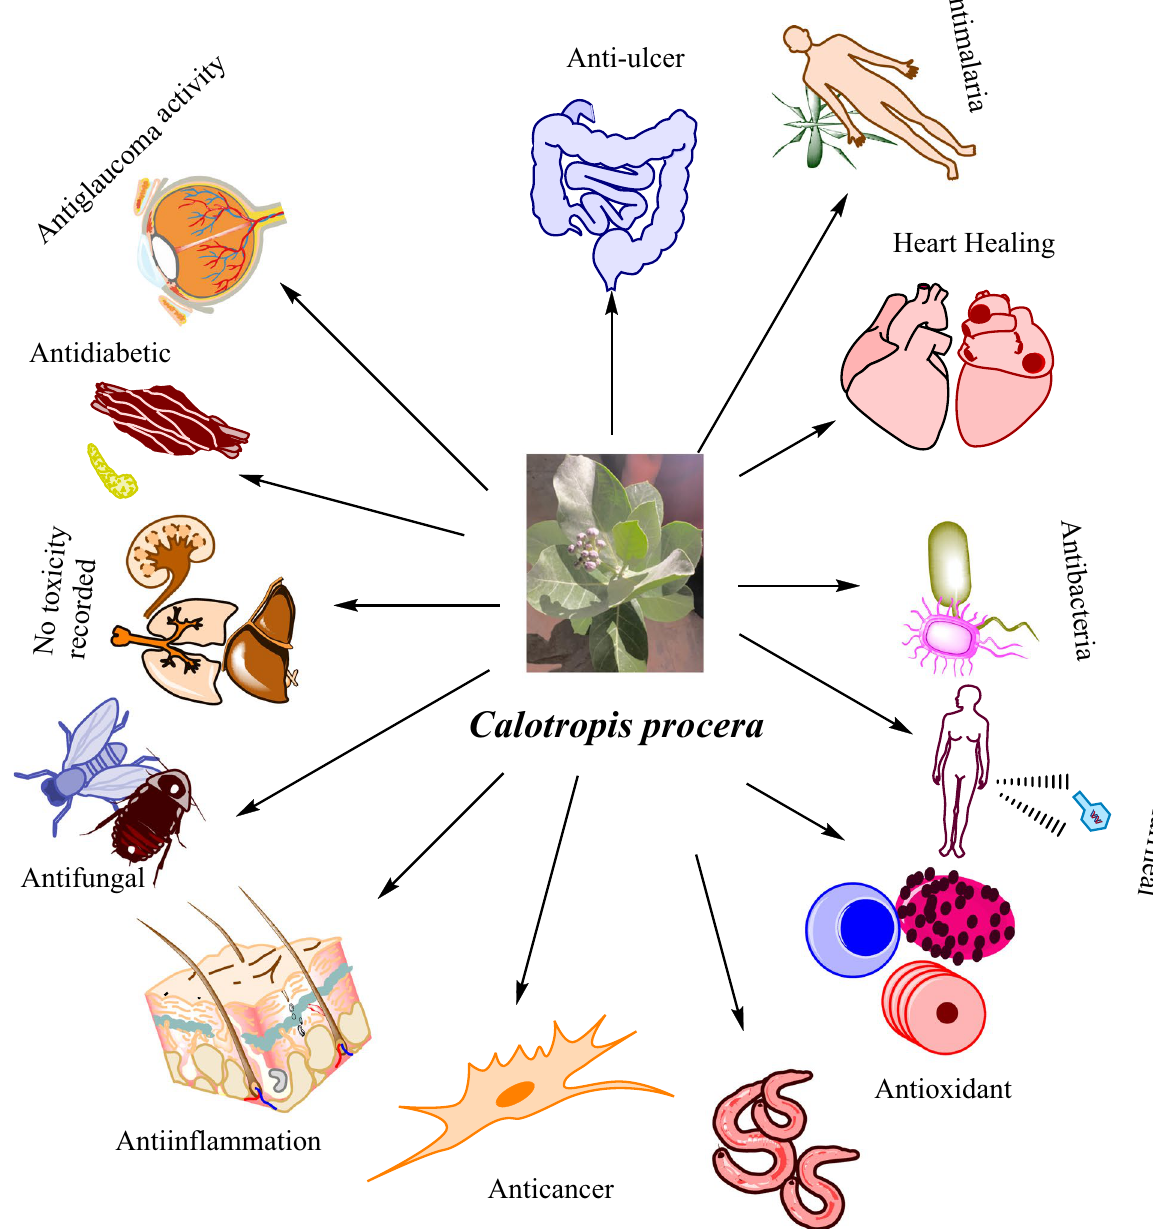
Fig. 2 Diseases treated with different parts of Calotropis